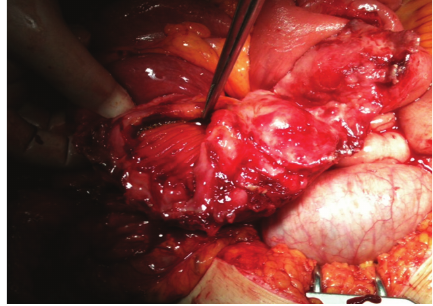
Figure 3: Perforation area on small bowel.